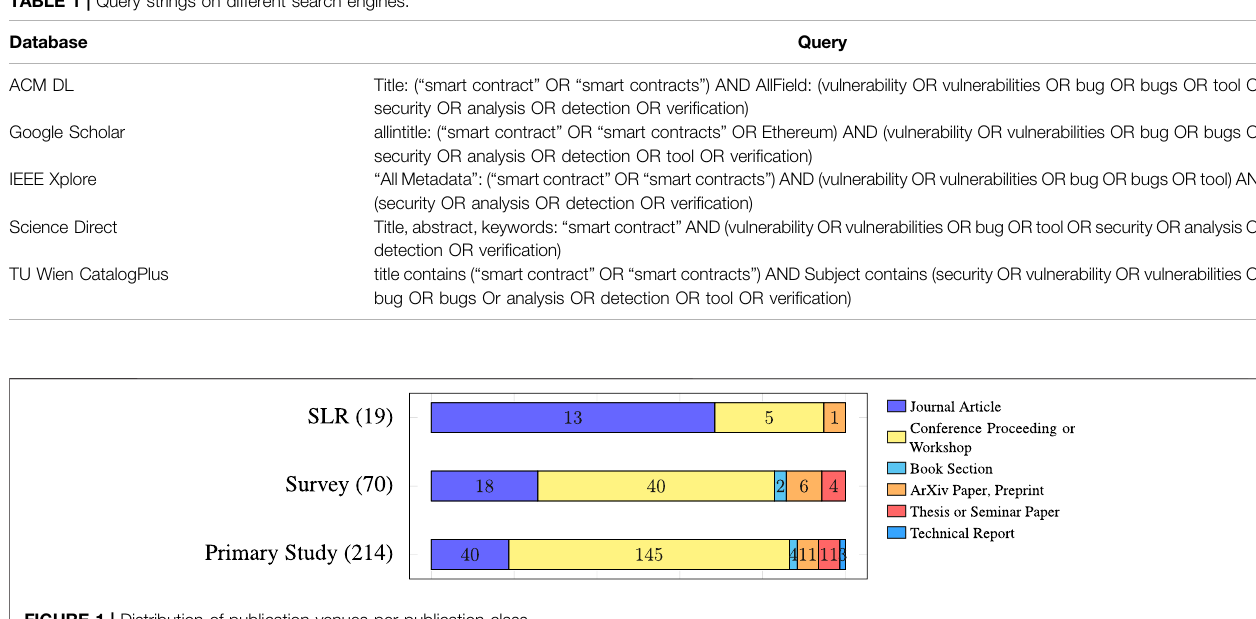
TABLE 1 | Query strings on different search engines.